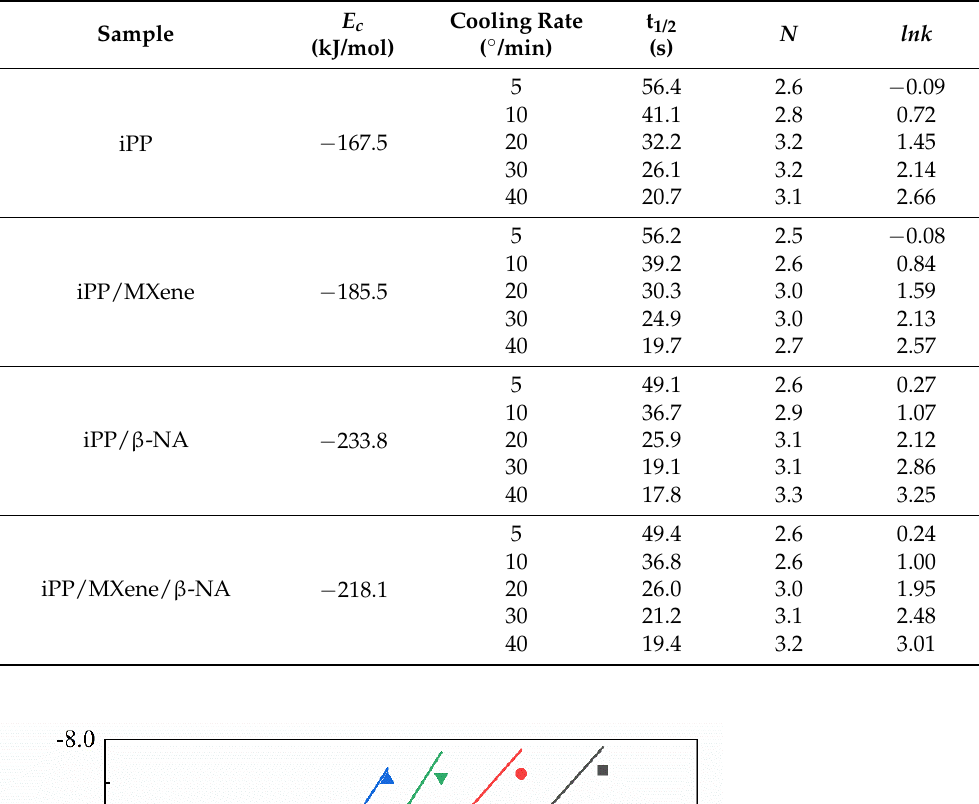
Table 1. Crystallization kinetics parameters of four samples at different cooling rates. E c represents the crystallization activation energy calculated by Kissinger plot. t 1/2 represents the half crystallization time calculated from the relative degree of crystallinity vs. time graph. n and lnk represent the Avrami exponent and crystallization rate constant calculated from Avrami and Jeziorny method.